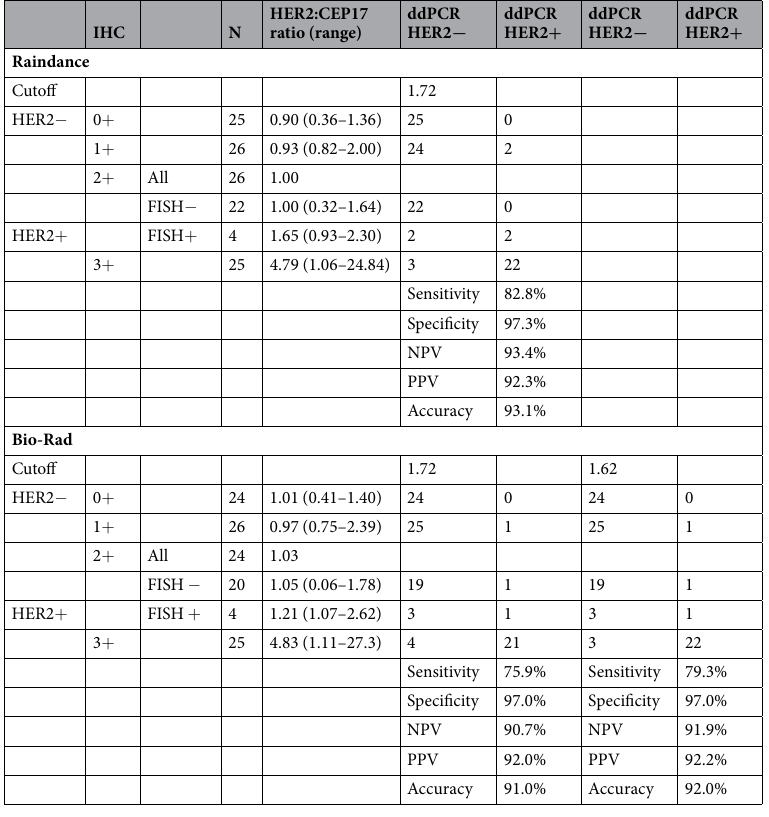
Table 1. Performance of RainDance and Bio-Rad ddPCR platforms on detection of HER2 amplification.